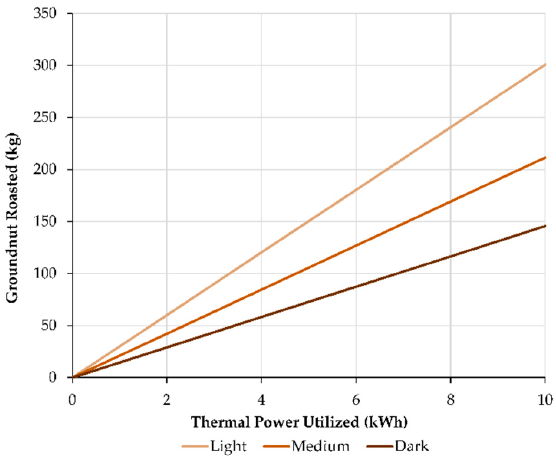
Figure 10. Solar thermal power utilization for roasting of groundnuts.